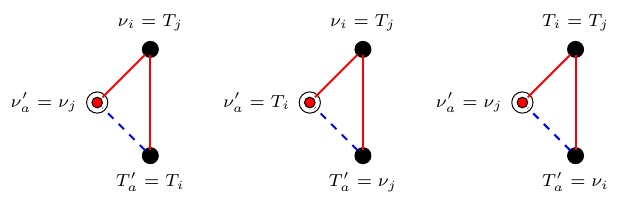
Figure 7.4: Cycles of length 3 including the verification query which is denoted by the concentric circle